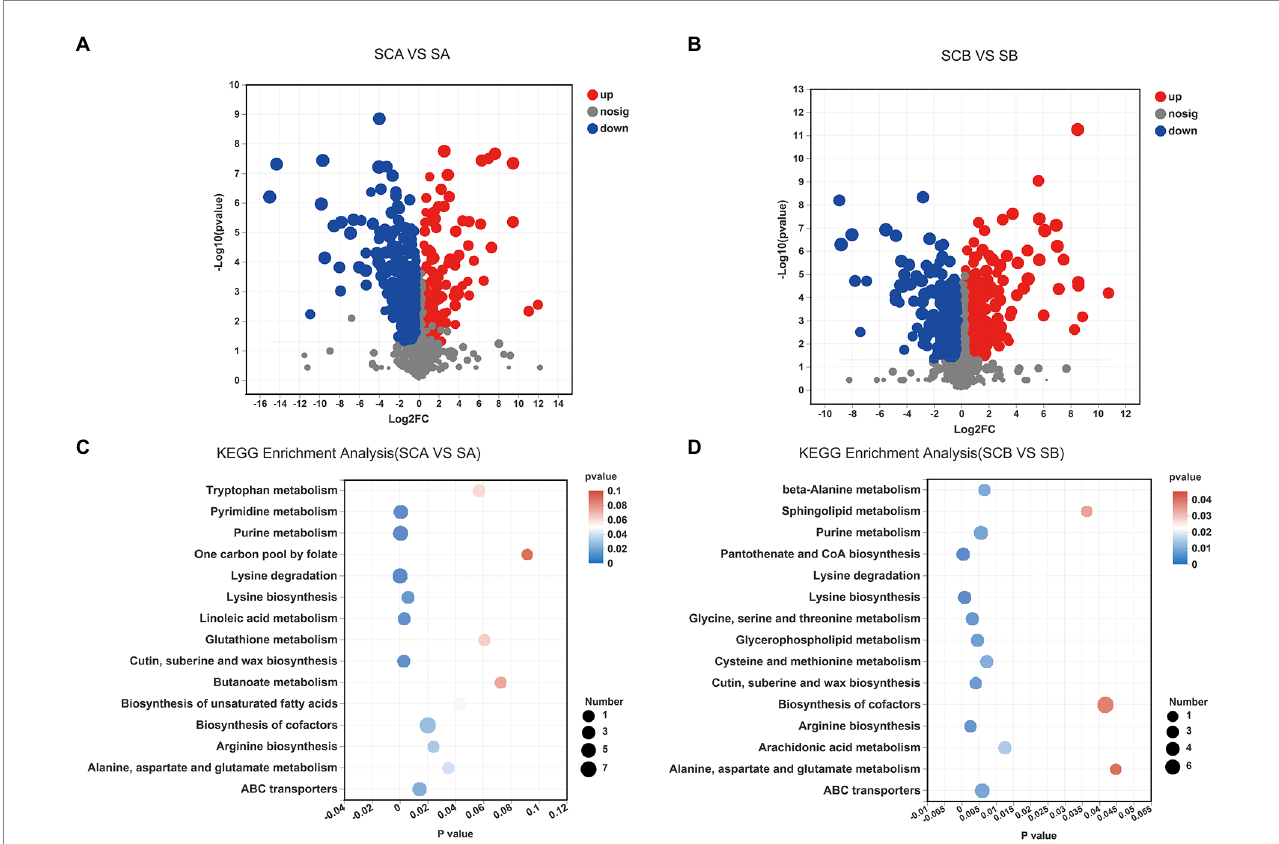
FIGURE 4 Volcano plot displaying the differences in intracellular metabolic profiles between pure culture and co-culture of E. amstelodami (A) and B. licheniformis (B) . Pathway analysis for intracellular metabolites of E. amstelodami (C) , B. licheniformis (D) pure culture and